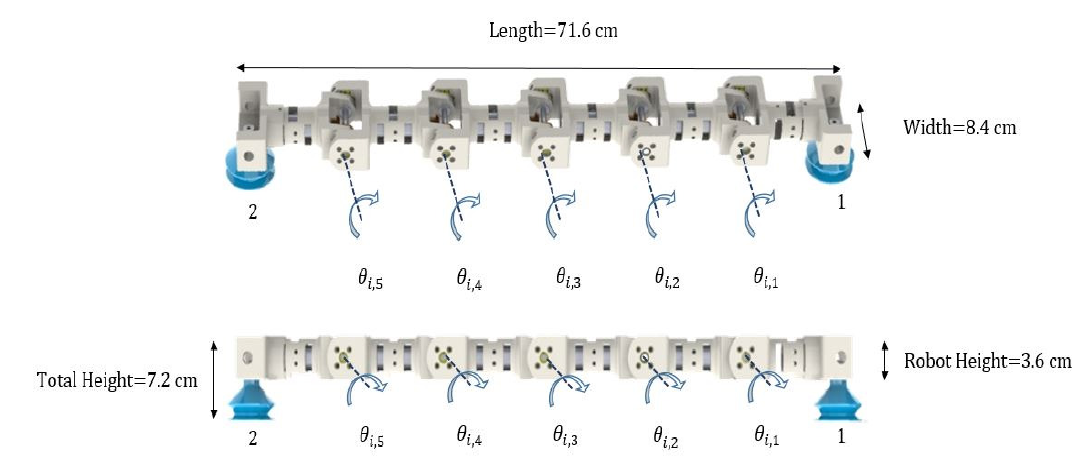
Figure 3. Dimensions of the